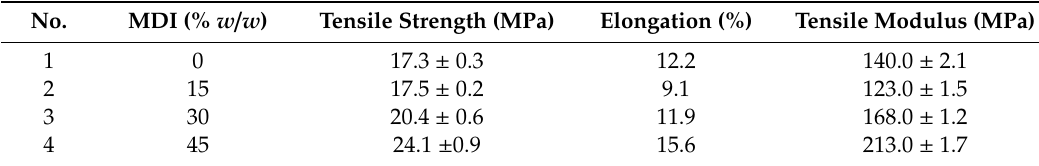
Table 3. Tensile strength and elongation percentage of the